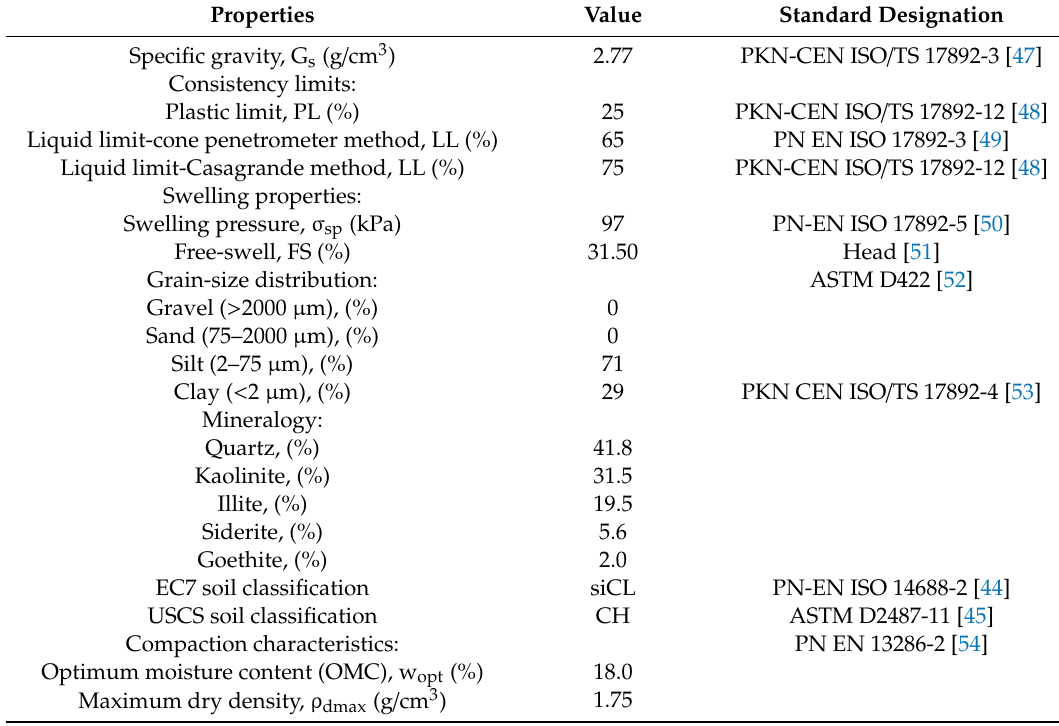
Table 1. Basic geotechnical properties of red clay (siCl / CH) [16,43].